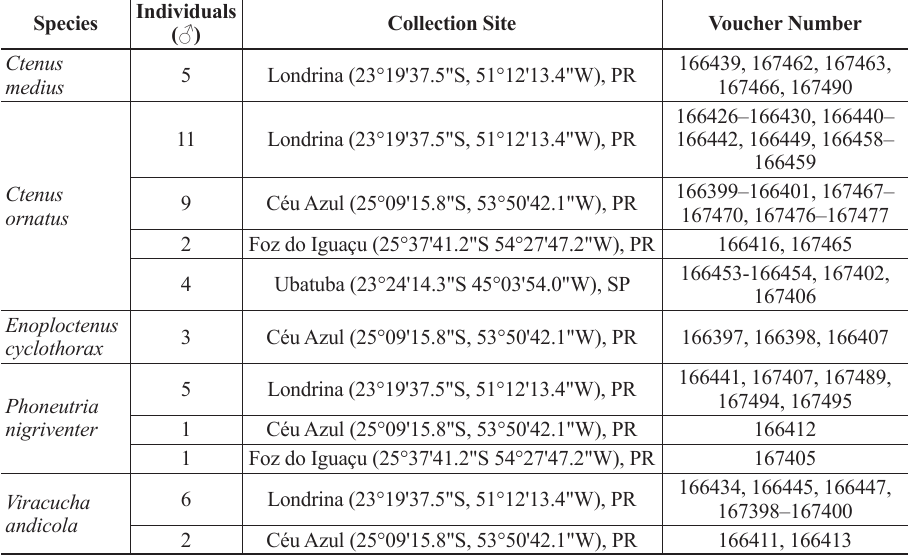
Table 2. List of collected species, with the number of the individuals, collection sites, and voucher num- bers. PR = Paraná State. SP = São Paulo